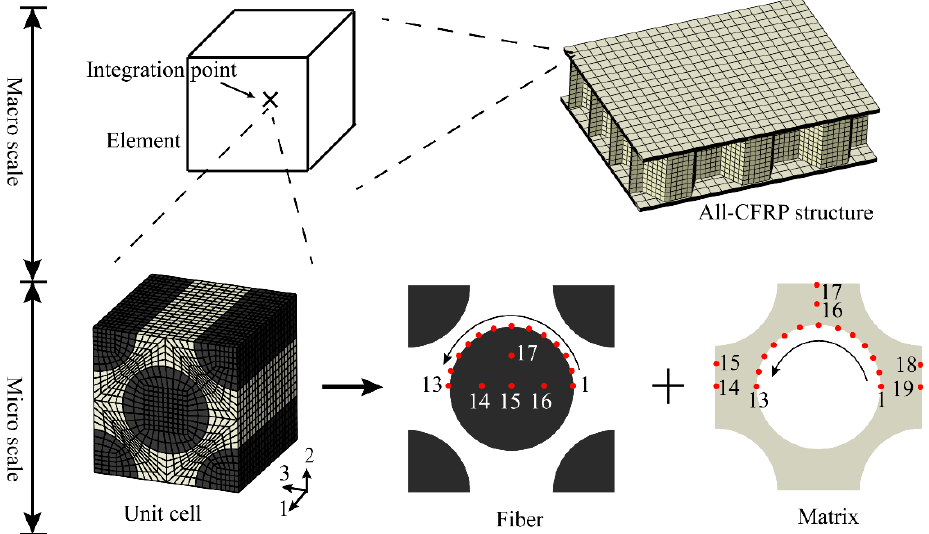
Figure 2. The MMF theory of fiber composites.